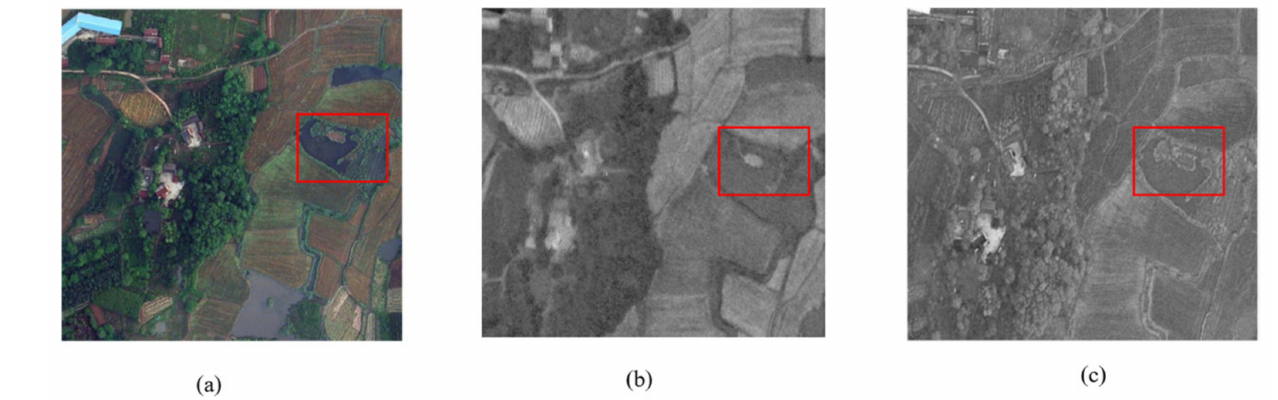
Figure 6. ( a ) The original image, ( b ) Visualization of features after BDE (a) operation, ( c ) Visualization of features after BDE (a) operation and BDE (b)